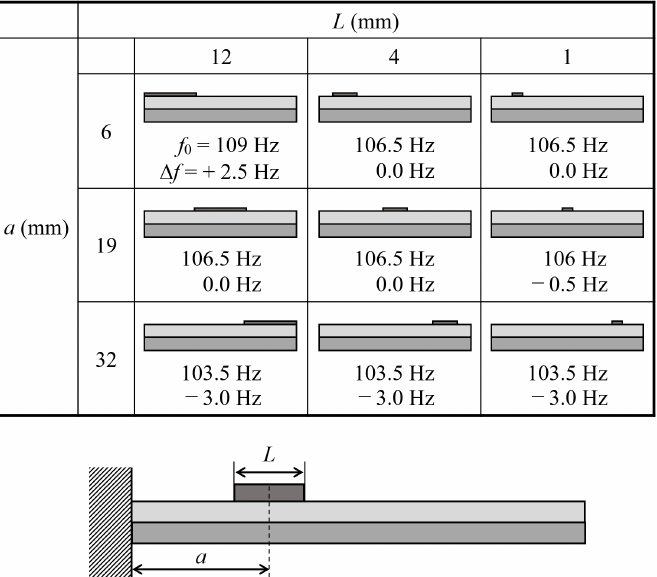
Figure 6. Calculated resonance frequency and frequency shift for various values of the distance between the proof mass and the clamped end and the length of the mass.